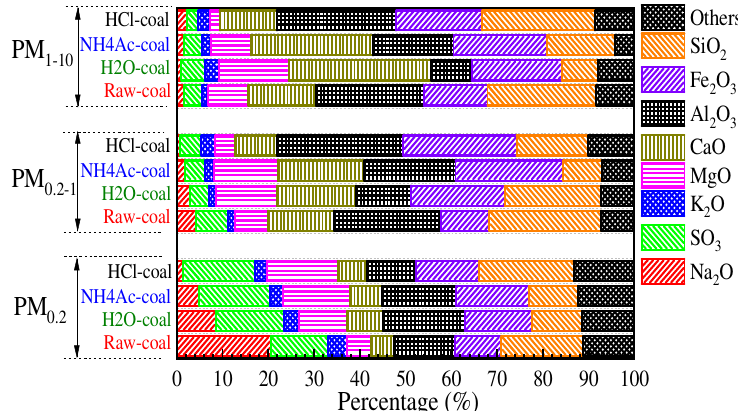
Figure 6. Major mineral in PM10 from CFA-treated coal samples.